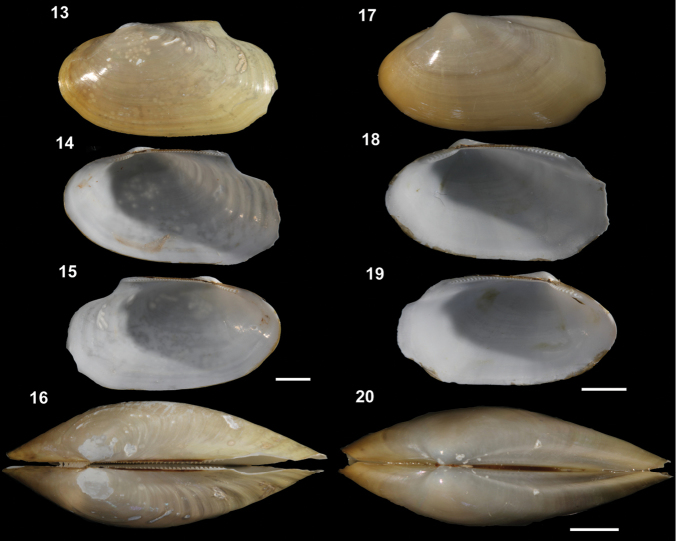
13–16Malletiaalata (Holotype LACM 2343) 13 External view 14–15 Internal view of the shell, right and left respectively 16 Dorsal view (total length = 30 mm) 17–20Malletiatumaquensis sp. n. 17 External view 18–19 Internal view of the shell, right and left valves, respectively 20 Dorsal view. Scale bars: 0.5 mm.